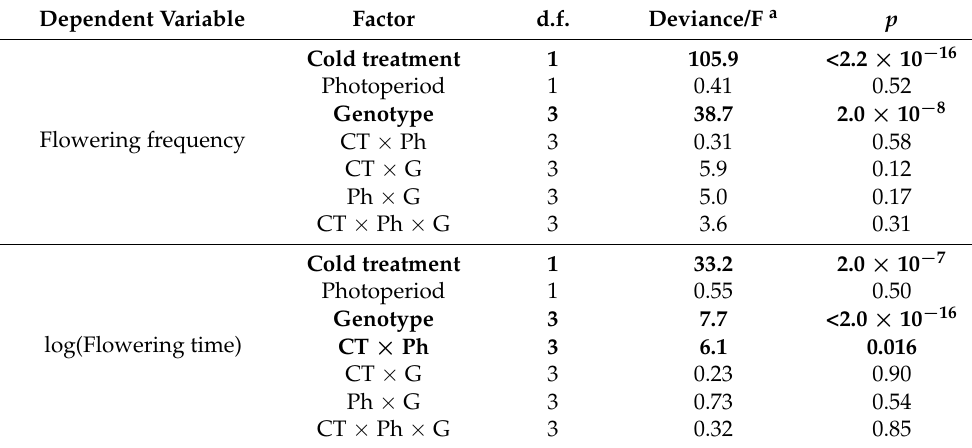
Table 1. Effect of cold treatment (CT), post-vernalization photoperiod (Ph), genotype (G), and their interactions on flowering time and frequency in